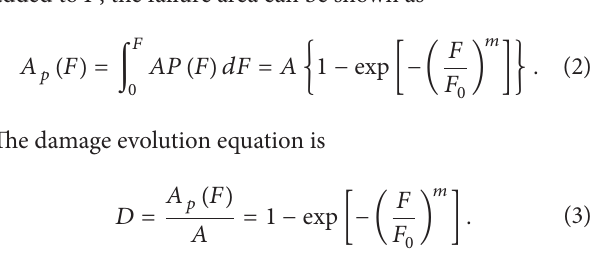
the effective stress on a microscale to increase. At the same time, due to the increasing effective stress, more defects are produced. Thus, the strength of the whole rock is reduced. Under the condition of continuous load, the changes of the damage in mechanical properties can be seen as a successive process approximately. In order to analyze the process conve- niently, the assumptions are shown as follows